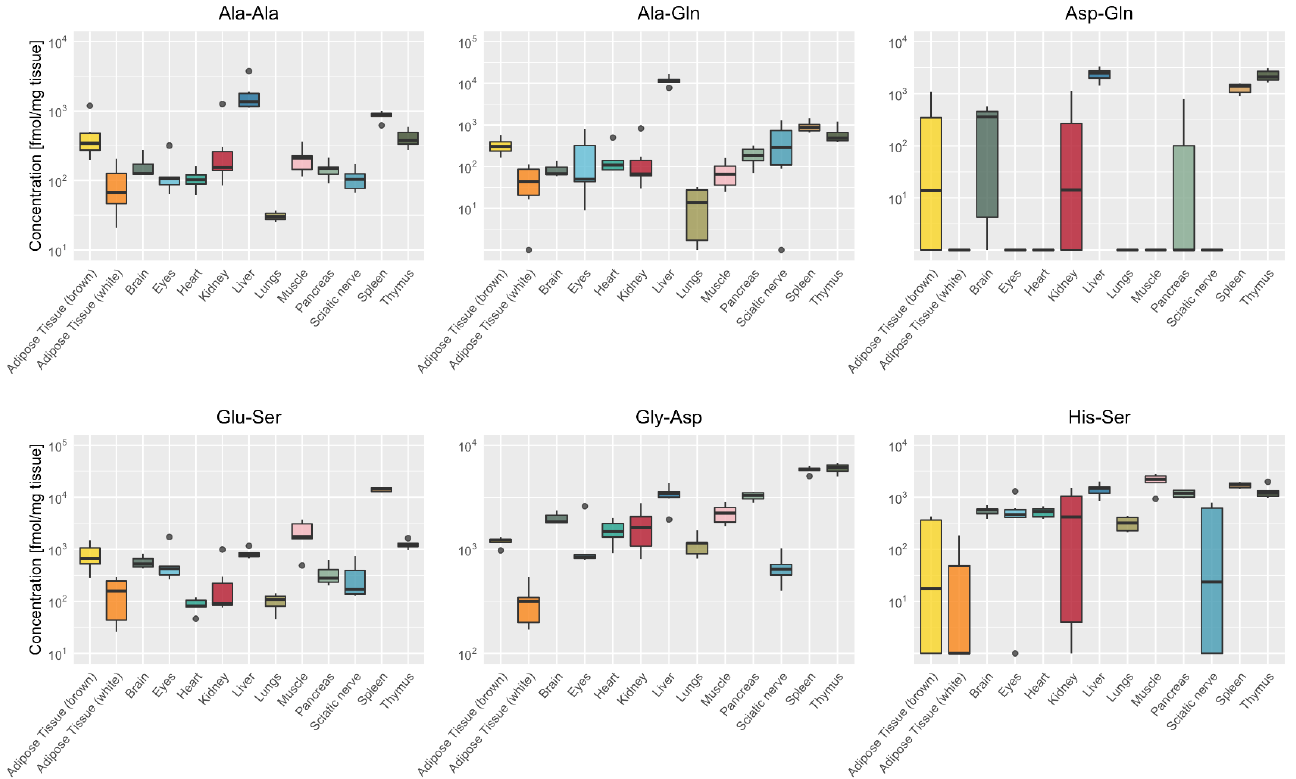
Figure 4. Organ-specific distribution of the six most abundant dipeptides (excluding anserine and carnosine). Box plots demonstrating the organ-specific distribution of the dipeptides Ala-Ala, Ala-Gln, Asp-Gln, Glu-Ser, Gly-Asp, His-Ser, showing median as bold line with standard deviation and ● indicating outliers ( n = 6). The two glutamine dipeptides (Ala-Gln and Asp-Gln) and Ala-Ala were the major dipeptides in liver, Glu-Ser in muscle and spleen, Gly-Asp in spleen and thymus and His-Ser in muscle.